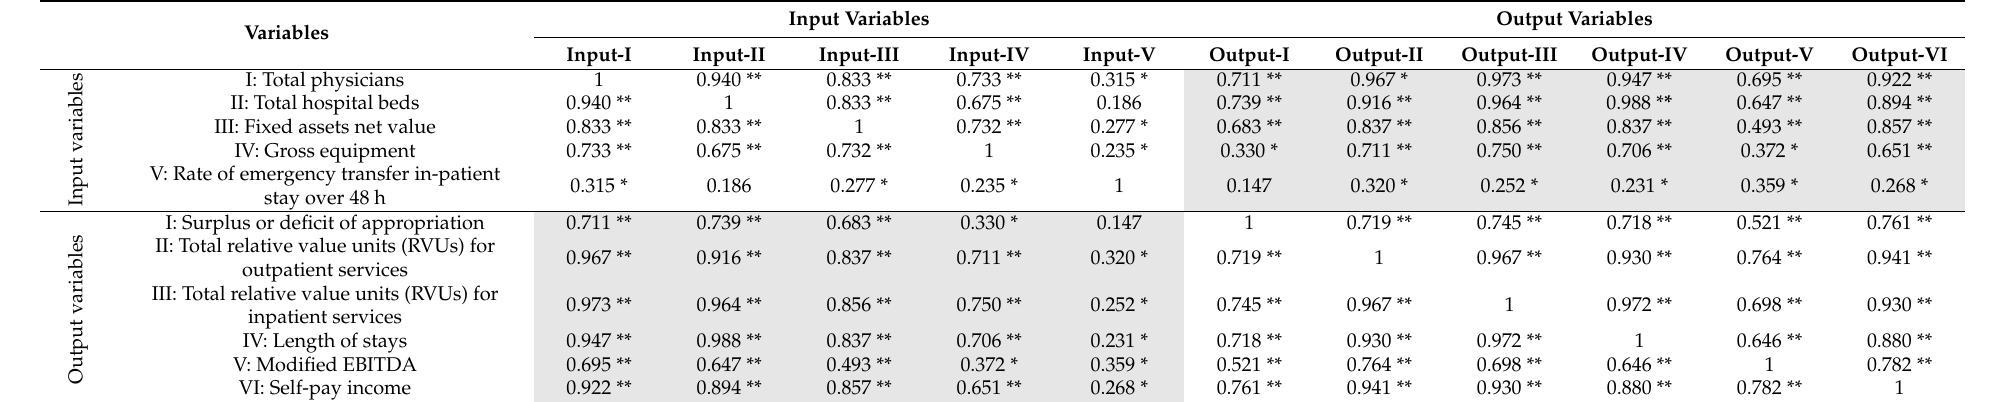
Table 4. Correlation coefficient analysis table of